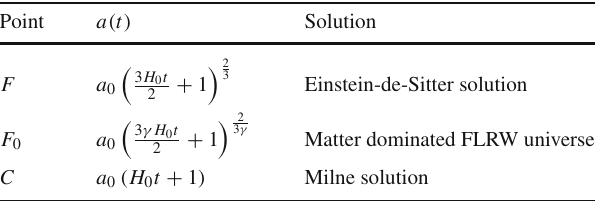
Fig. 4 Phase space of the guiding system (78a), (78b), (78c) for γ = 1 Table 2 Exact solutions associated with equilibrium points of reduced averaged system (107a)–(107b). a ( t ) denotes a scale factor of metric (28) and a 0 ∈ R